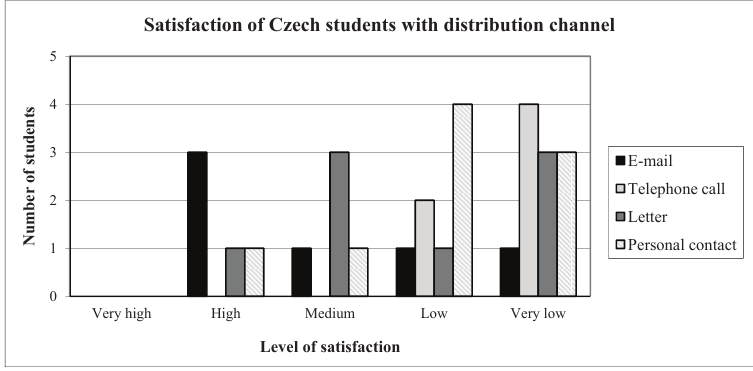
Fig. 5 - Satisfaction with the bank distribution channels among Czech students. Source: Author´s own.